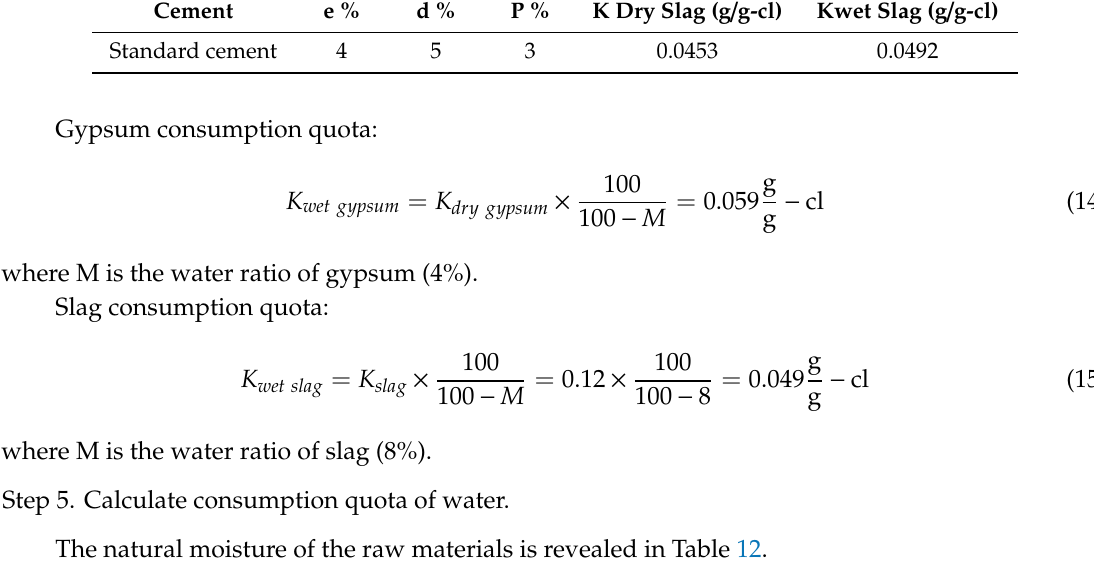
Table 12. The natural moisture of the raw materials (%).